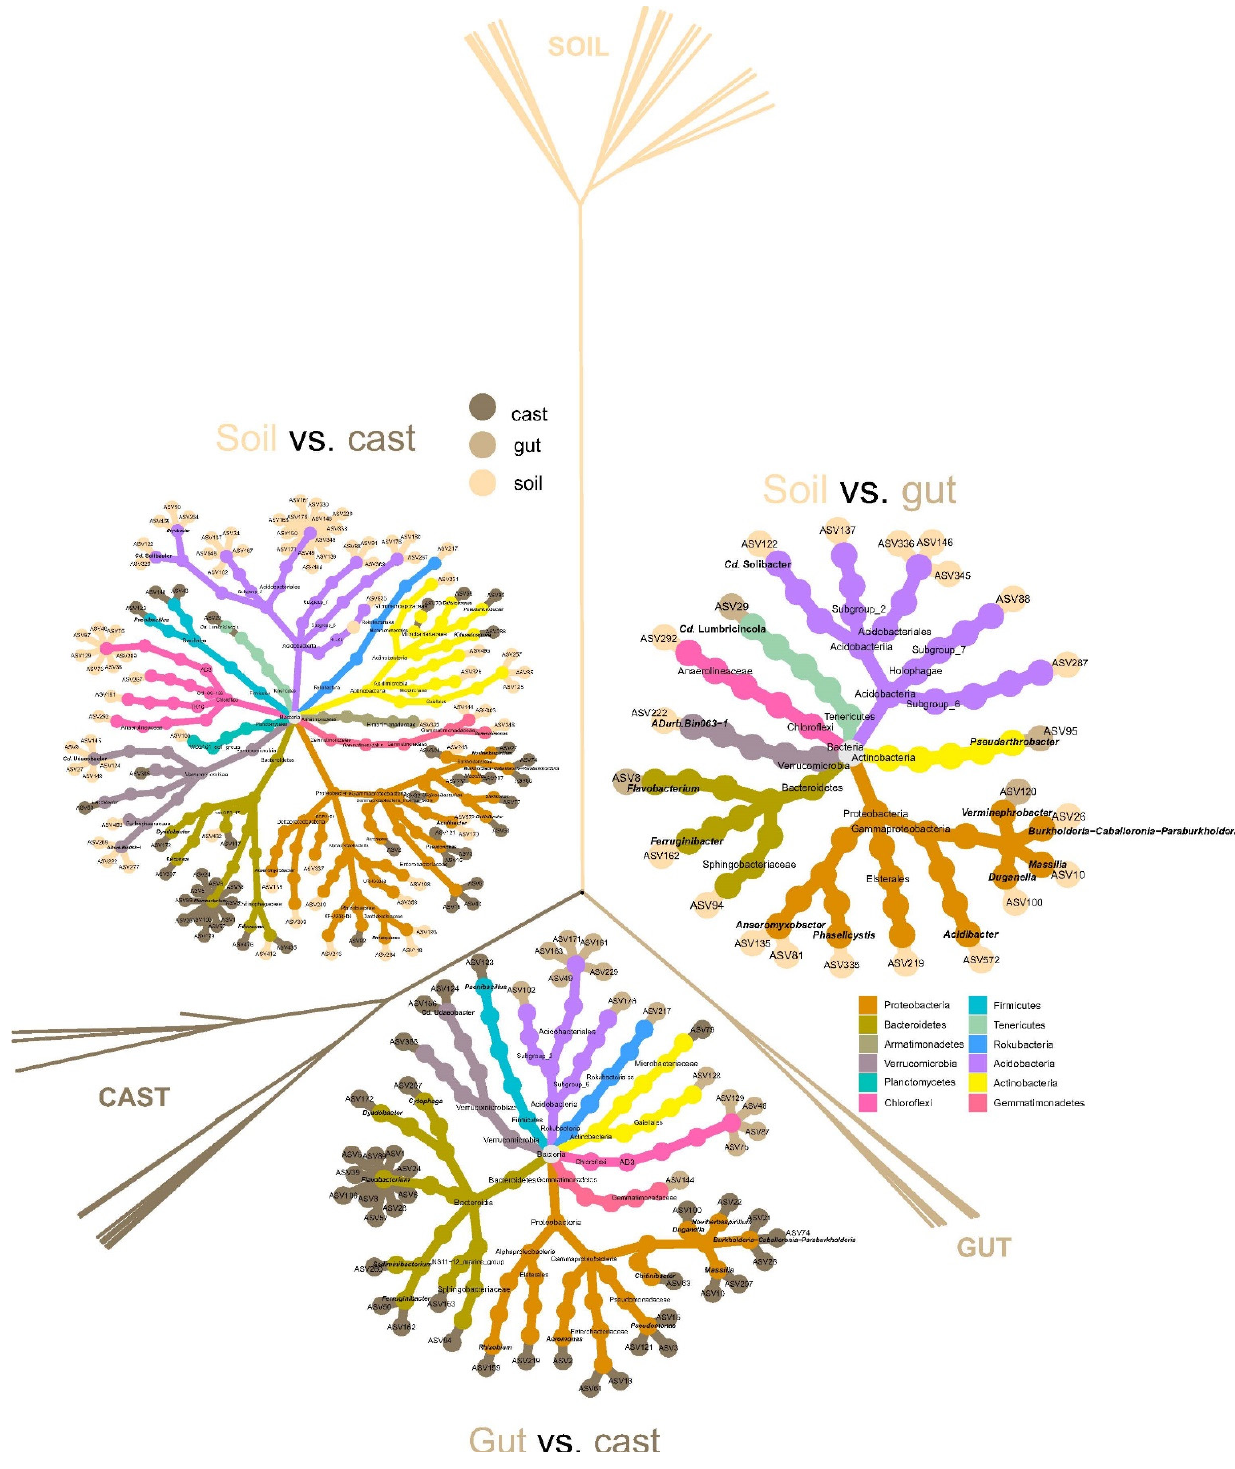
Figure 2. Changes in bacterial ASV abundance and structure of soil microbiome during and after gut transit in the earthworm Aporrectodea caliginosa . The dendrogram represents the dissimilarity of bacterial communities at ASV level (variance stabilized matrix of counts, unweighted UNIFRAC distances, Ward method). Heat trees show changes in bacterial composition across taxonomic ranges of soil samples during and after gut transit in the earthworm Aporrectodea caliginosa . Each tree shows bacterial ASVs with significant differential abundance after DESeq2 pairwise comparisons between soil, gut and cast samples. ASVs are colored according whether they were more abundant in soil, gut or cast. Rhizobium and Burkholderia classification are Allorhizobium-Neorhizobium-Pararhizobium- Rhizobium and Burkholderia − Caballeronia − Paraburkholderia,